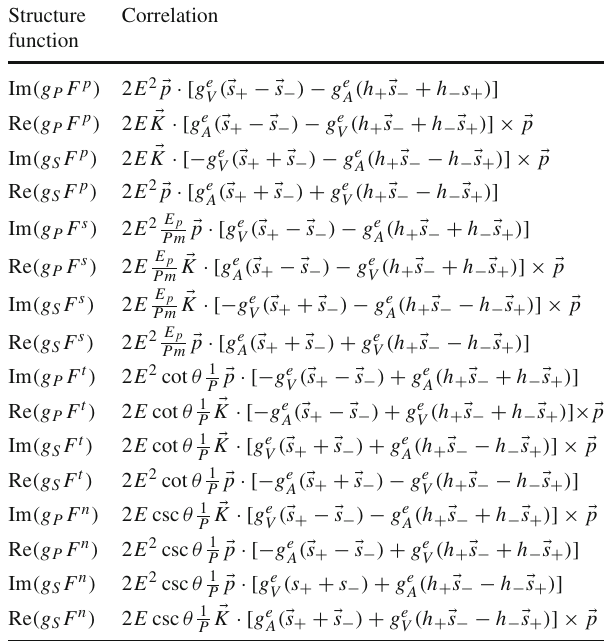
Table 1 Correlations due to structure functions for scalar and pseudo- scalar BSM physics from the interference of the SM amplitude with the BSM physics. An overall factor of 8 has been suppressed to be consistent with published results, Refs. [11,12]. Note the symmetry of the correlations under the simultaneous interchange of Im ↔